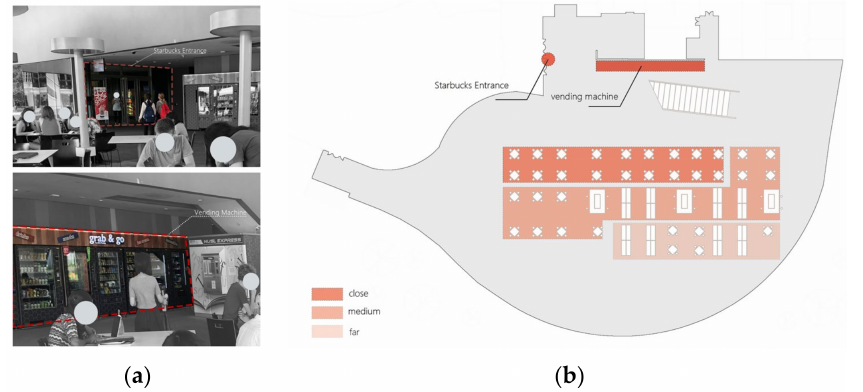
Figure 9. Food location and seating division: (a) actual view of the food location and ( b ) schematic diagram of food accessibility